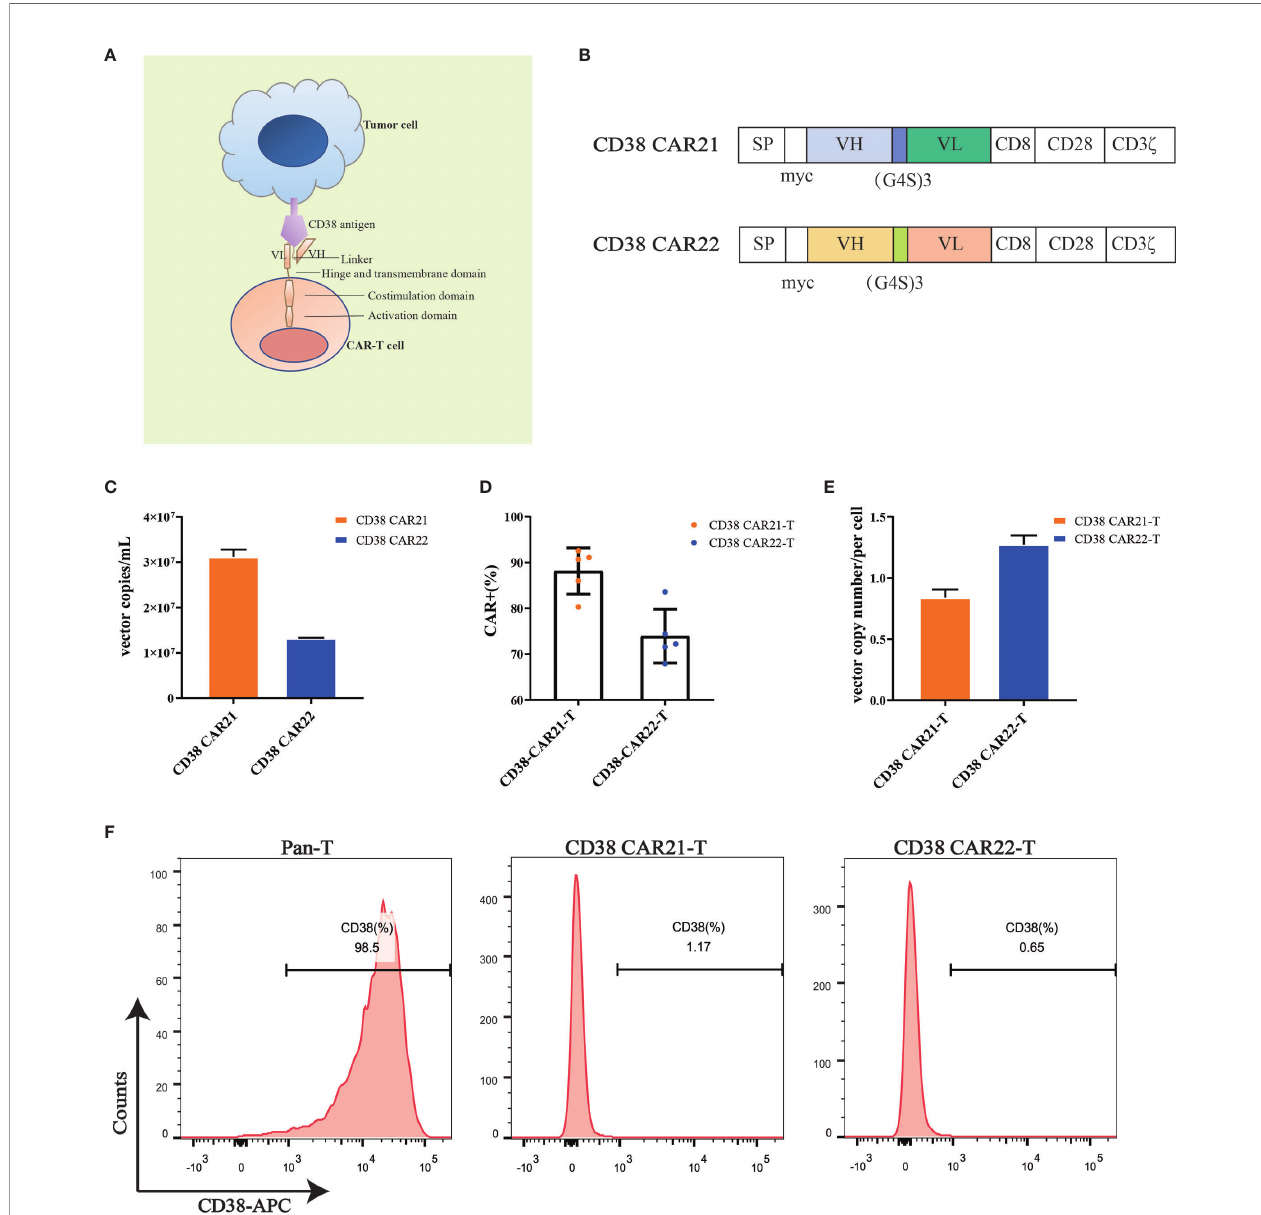
FIGURE 1 | CD38 CAR construct and expression on primary T cells. (A, B) The construction of two CD38 CARs. The CD38-ScFv sequences were selected from two different CD38 antibody sequences (CAR21 and CAR22) with the CD8 hinge and transmembrane region, the CD28 cytoplasmic costimulatory region and the CD3 z signaling domain. (C) The copy numbers of supernatant viral vectors produced by the PG13 cell line were detected by RT-qPCR. (D) The transduction ef fi ciency of CD38 CAR in primary T cells from different donors (n= 5). The transduction ef fi ciency was de fi ned as the percentage of CD3-positive and myc-positive cells among total live cells. (E) The vector copy number of CD38 CAR integration per primary T cell was detected by RT-qPCR. (F) The expression of CD38 on the surface of human primary T cells transduced with the CD38 CAR was detected by fl ow